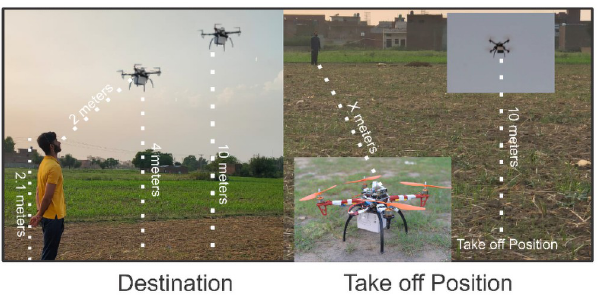
Fig 4. Experimental setup of the proposed Consumer-Auth